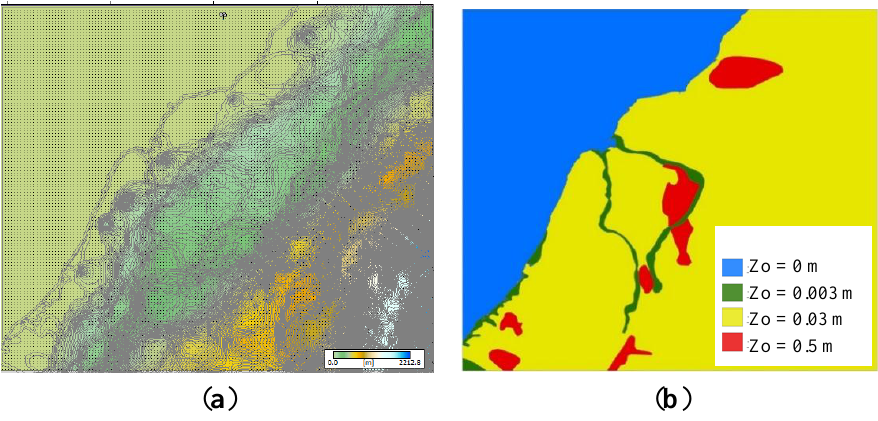
Figure 3. Contour map and surface roughness diagram in the Miaoli area. ( a ) 5-m contour map; ( b ) Surface roughness diagram.